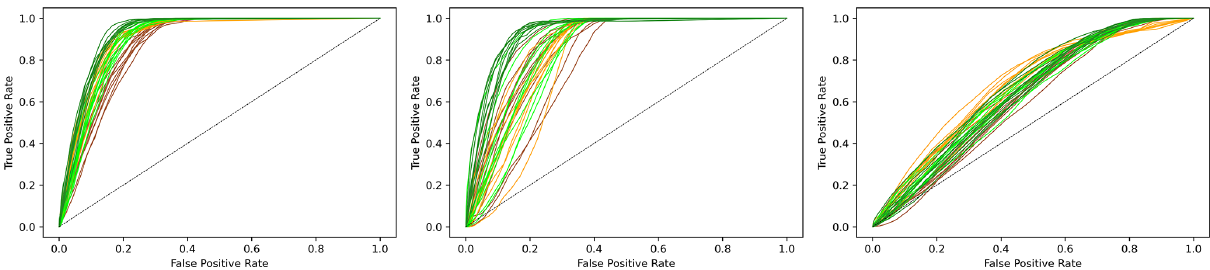
Figure 10. ROCs of the 10 runs per vegetation scenario from Table 8. Orange: global uniform vegetation; light green: forest area uniform vegetation; dark green: single-tree detection; brown: no vegetation. Corresponding study areas from left to right are as follows: Eriz, Trub and